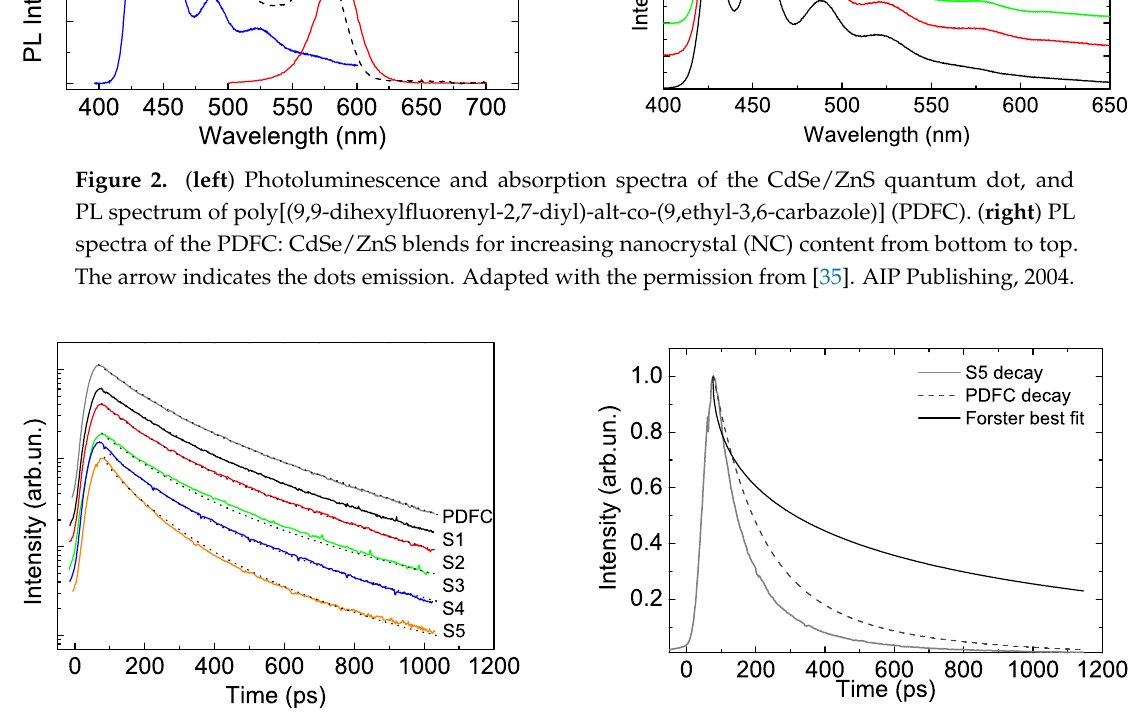
Figure 3. ( left ) Relaxation dynamics of the PDFC: CdSe/ZnS blends for increasing NC content from top to bottom. The dotted lines are the best fit curves. ( right ) Different contributions to the PL relaxation of the PDFC: CdSe/ZnS blend with a CdSe/ZnS content of 1.1%. Adapted with the permission from [36]. AIP Publishing,